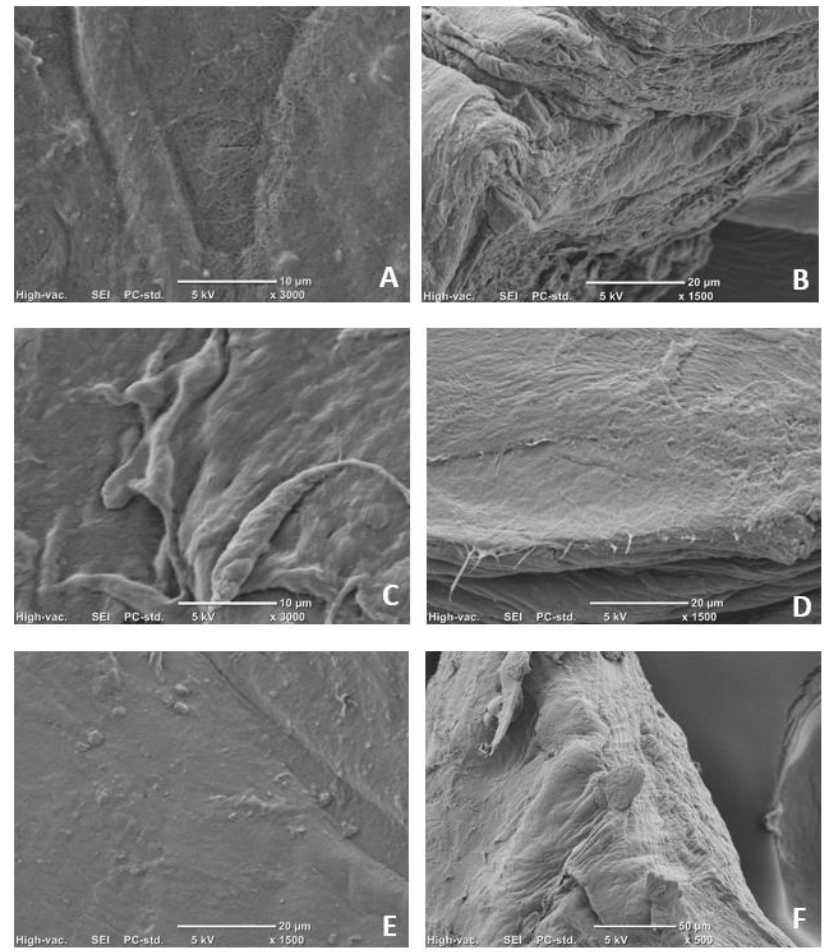
Figure 2. SEM images of materials. Image ( A , B ) bacterial cellulose pre-treated and modified with glycerol; ( C – F ) bacterial cellulose pre-treated and modified with glycerol and then entrapping apple powder at concentrations of 10% ( C , D ) and 50% ( E , F ). Images ( A , C , E ) show the view of the surface, whereas ( B , D , F ) show edges.